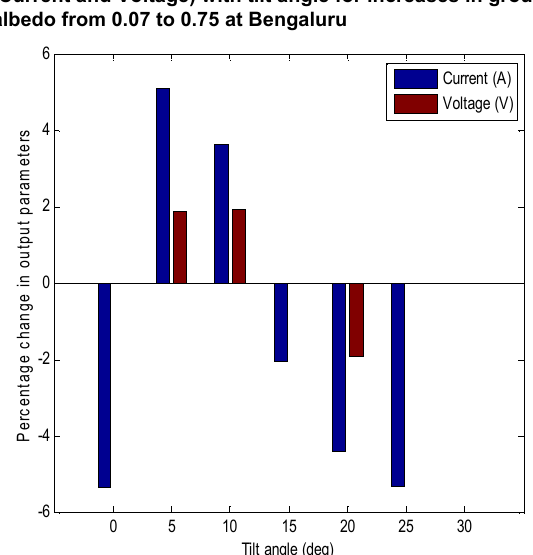
Figure 6(d). Percentage change in output parameters(Current and Voltage) with tilt angle for increases in ground albedo from 0.07 to 0.75 at Thiruvananthapuram